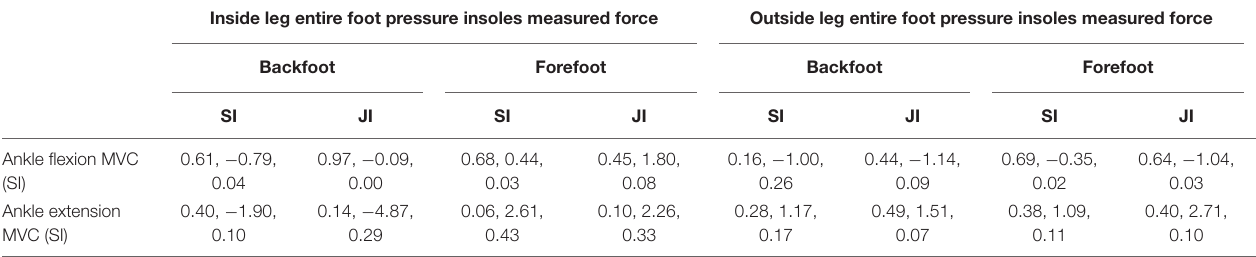
TABLE 5 | Triplets ( p -value, coefficient in the linear regression model, R 2 ) for each pair: independent (laboratory) variable (rows) and dependent (on-snow) variable (columns) used for testing hypothesis